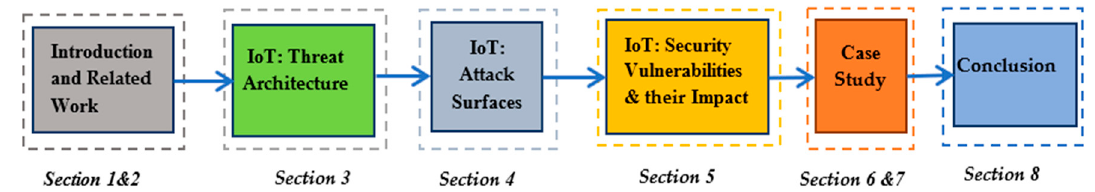
Figure 3. Roadmap of the Article.